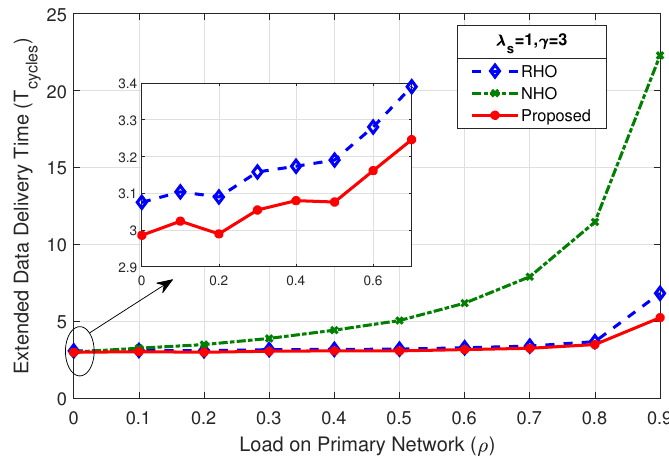
Figure 8. Comparison of mean EDDT for λ s = 1, γ = 3.